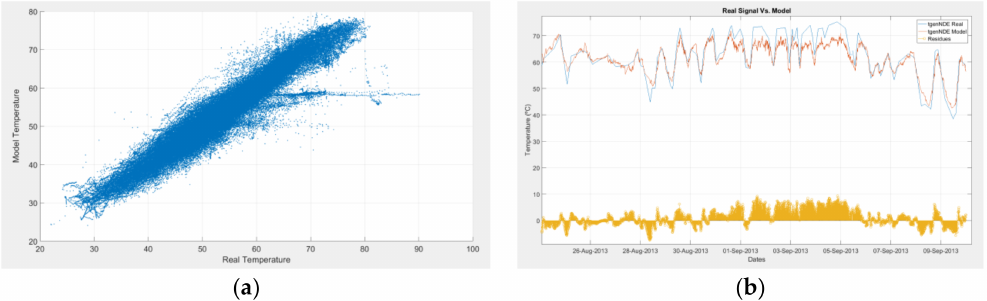
Figure 9. Specific Model After Correction: ( a ) Regression line; and ( b ) real temperature (in blue) and estimated temperature (in red) of the NDE bearing, and residues of the model (in